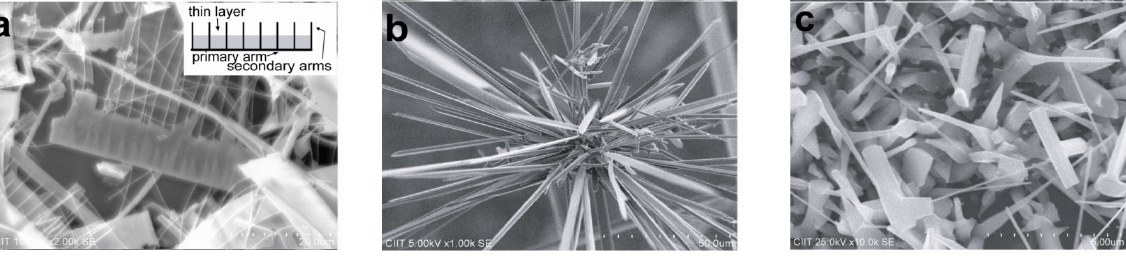
Figure 1. SEM images of different morphologies of ZnO Nanostructures at different synthesis temperatures. ( a ) Comb-like structures at 950 °C. The inset shows the schematic diagram of these combs; ( b ) Nanobelts with needles at 925 °C; ( c ) Mixture of rod and belts at 900